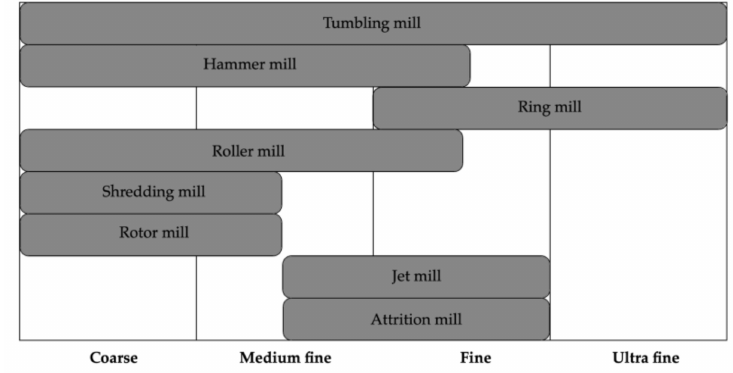
Figure 2. Schematic representation of the type of mill and the size ranges of the desired